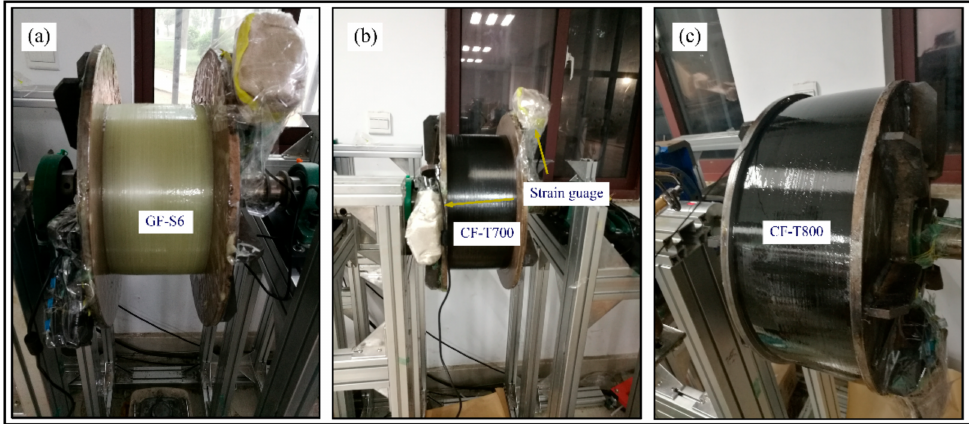
Figure 4. Winding process of: ( a ) glass fiber GF-S6, ( b ) carbon fiber T700, and ( c ) carbon fiber